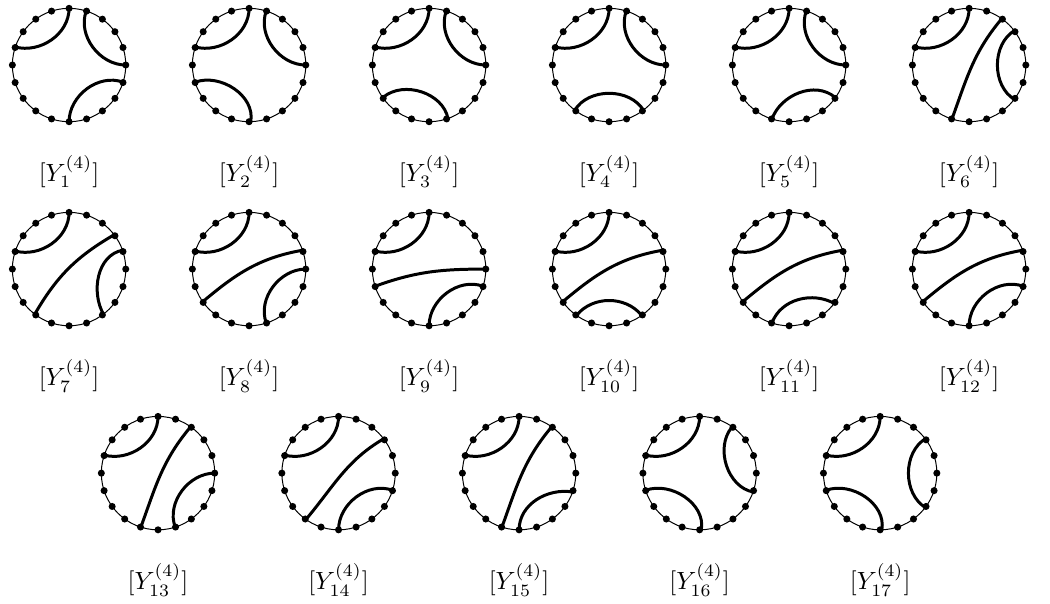
Figure 5. The 17 cyclically distinct weak separation graphs for n = 20 ; k = 4. Each corresponds to the indicated cyclic class [ Y (4) (cid:11) ] of extremal Yangian invariants containing the element Y (4) (cid:11) given in